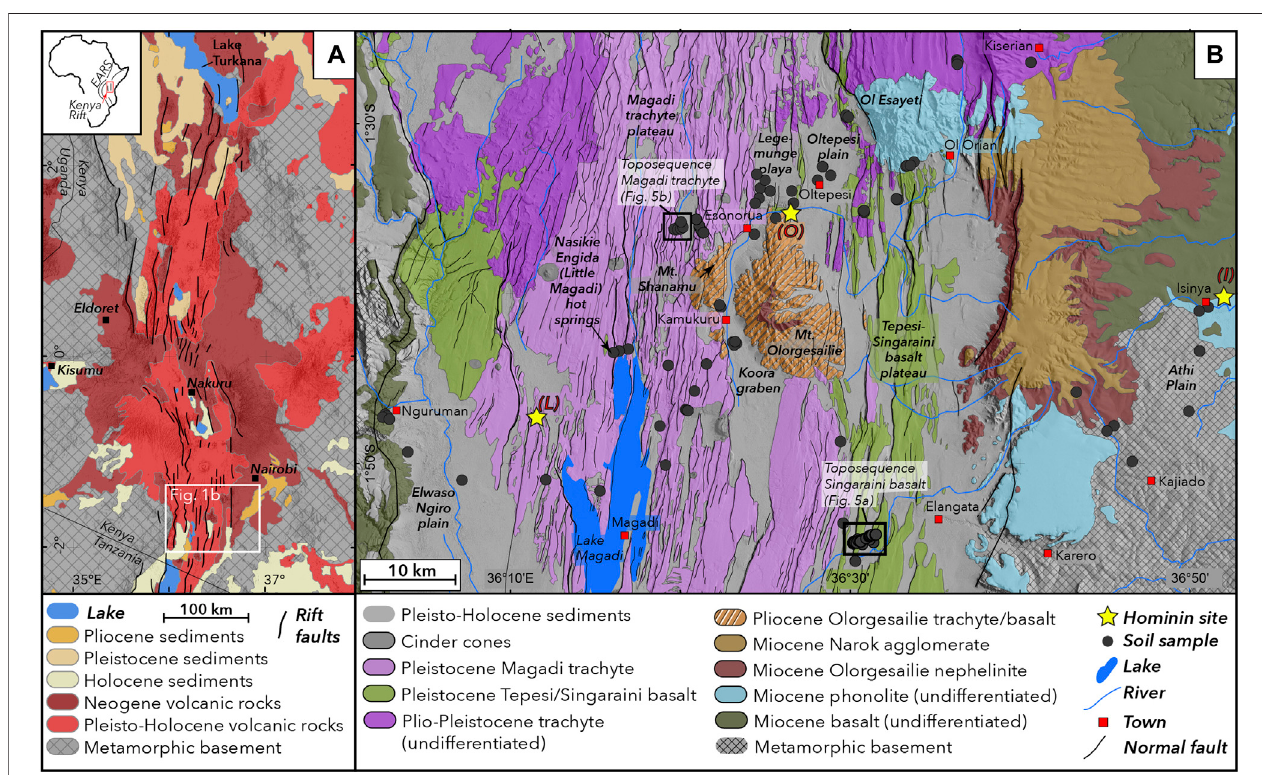
FIGURE 1 | Geological setting of the study region. (A) Geological frameworkof the Kenya Rift depicting the main lithological and tectonic features. (B) Geological framework and sampling locations of the study region in the southern Kenya Rift (geological data from Guth et al., 2013). Black boxes depict locations of two toposequences shown in Figure 5 ; yellow stars indicate locations of hominin fossil sites: (I) Isinya, (L) Lainyamok, (O) Olorgesaile.